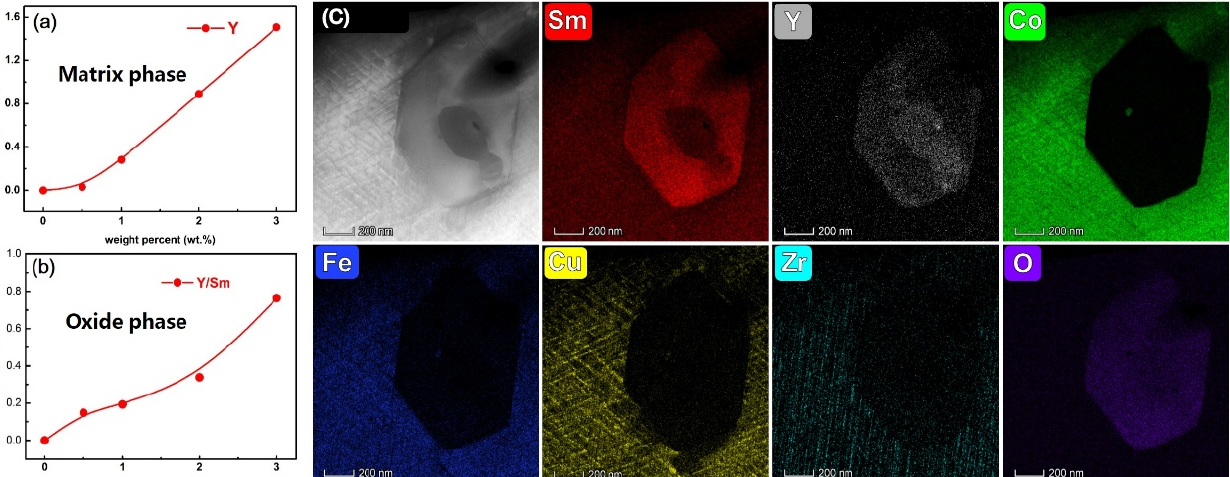
Figure 3. The content of Y in matrix phase ( a ) and the atomic ratio of Y and Sm in the oxide ( b ), HAADF images ( c ) and their EDS elemental distributions for the matrix phase around the Sm-Y oxide in magnets with 1 wt.% addition.